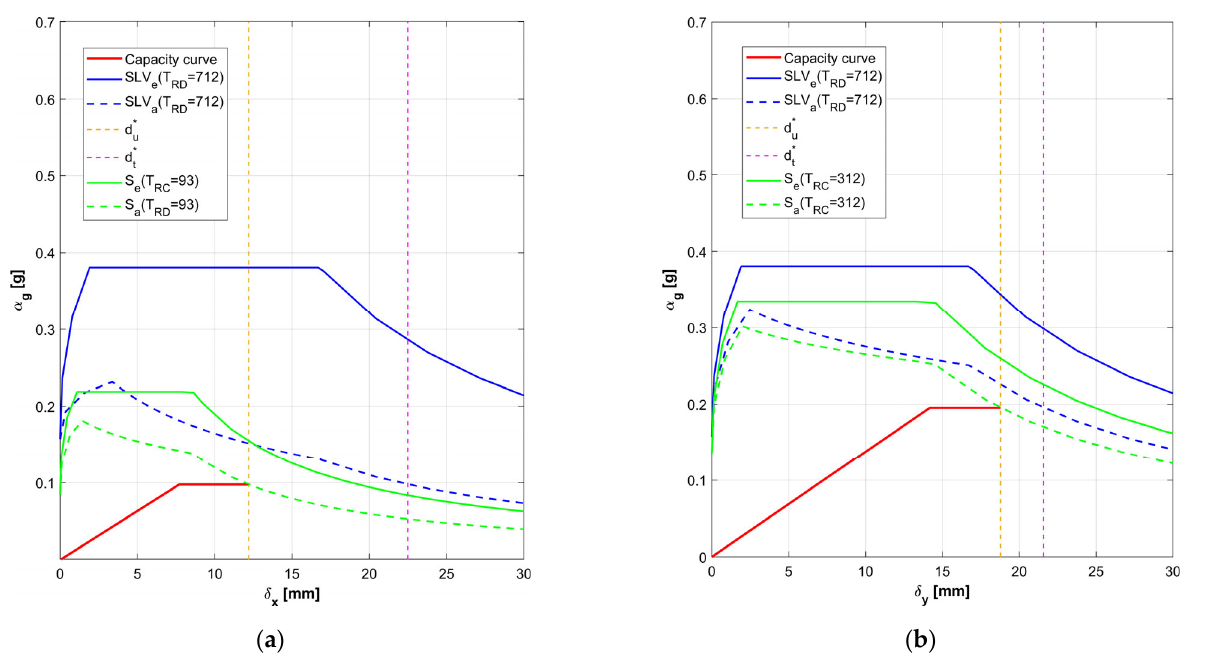
Figure 12. Final output of the global pushover analysis of the building in the case of strengthening intervention, consisting of the introduction of horizontal steel bracing systems at the floor level, aiming to achieve a box behavior. Verification in the acceleration-displacement response spectra (ADRS) plane: ( a ) x -direction, I R = 0.55 , ( b ) y -direction, I R =